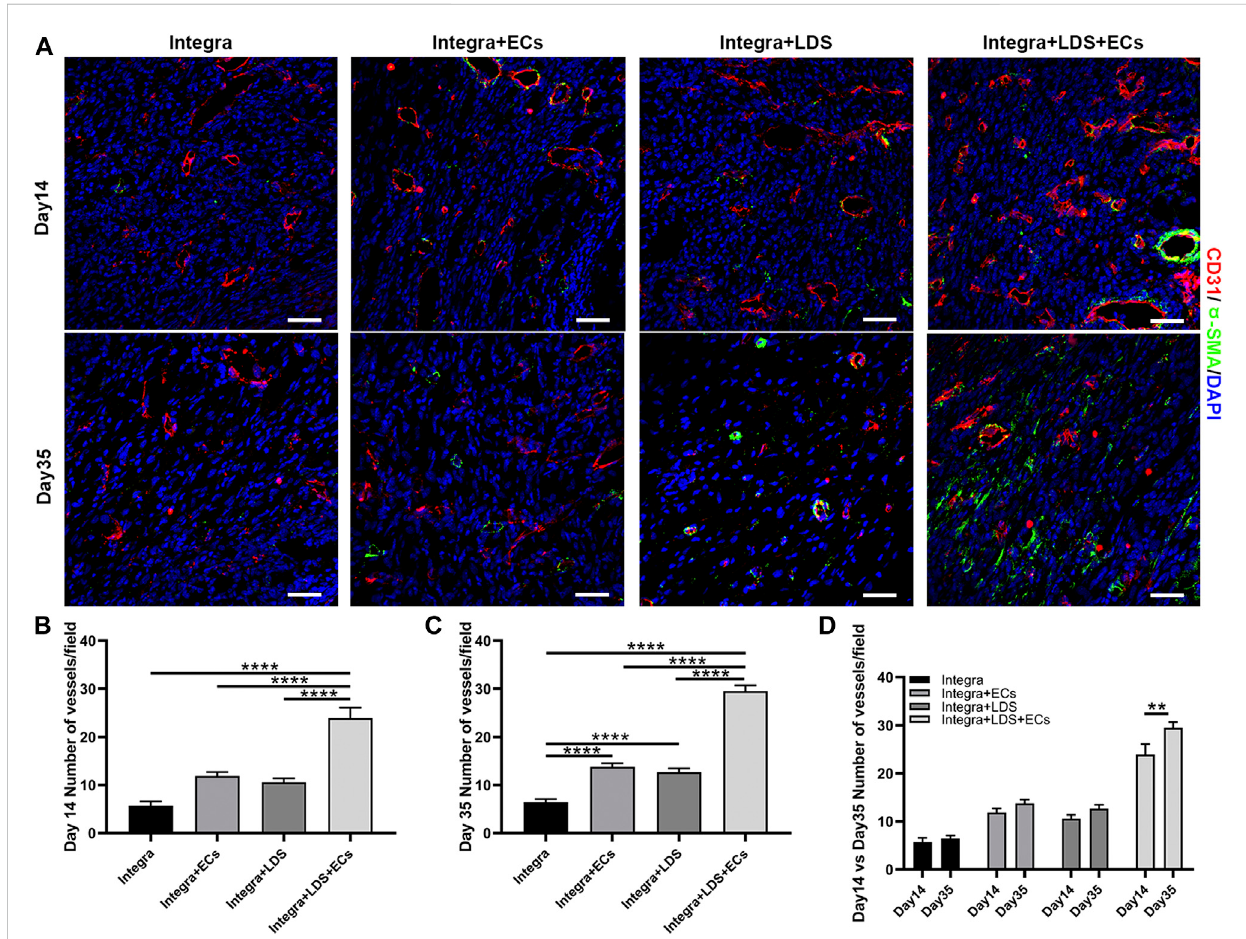
FIGURE 6 Immuno fl uorescence staining of CD31 and α -SMA in wound samples on Day 14 and Day 35. (A) Representative images of CD31 and α -SMA co- immunostaining in all groups at Day 14 and Day 35. Scale bar = 50 μ m. (B – D) Quantitative data of newly formed vessels per fi eld on Day 14 and Day35. Data are expressed as mean ± SEM. * p < 0.05, ** p < 0.01, *** p < 0.001, and **** p <